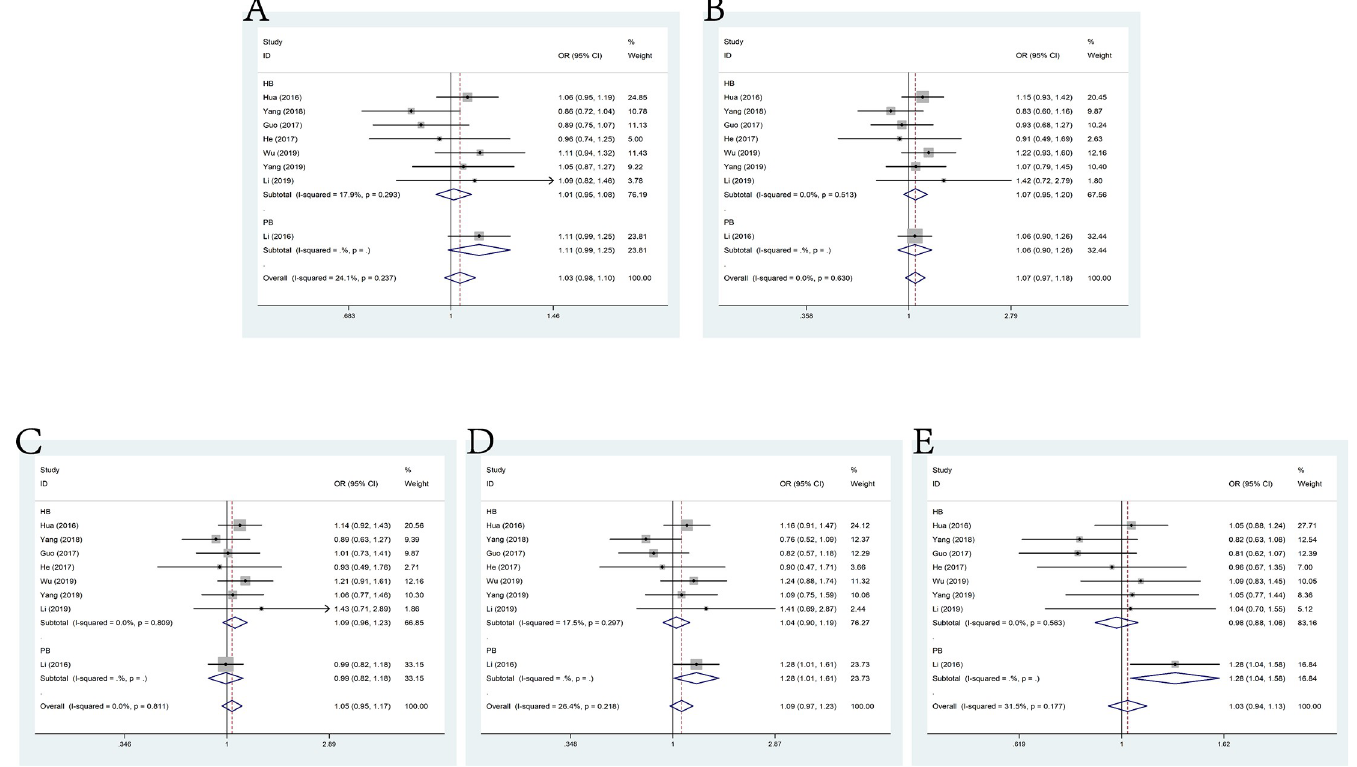
Fig 6. Forest plot of the association between H19 polymorphism rs3024270 C > G and cancer susceptibility. A: allele model; B: dominant model; C: heterozygote model; D: homozygote model; E: recessive model.